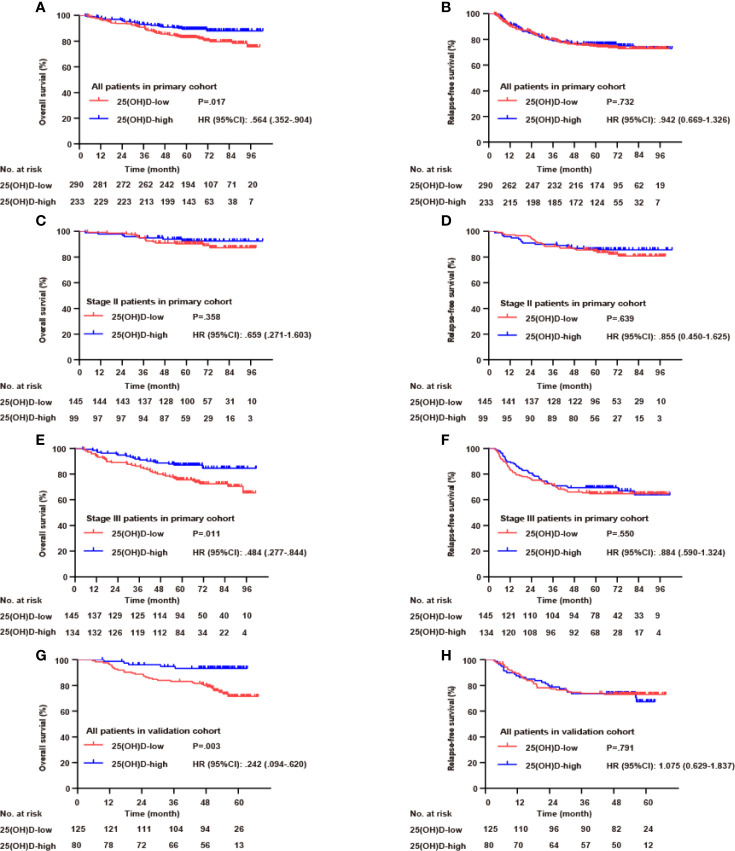
Serum 25(OH)D as a prognostic biomarker in both cohorts. Overall survival (A) and relapse-free survival (B) curves according to serum 25(OH)D levels among patients with CRC in the primary cohort. Overall survival (C) and relapse-free survival (D) curves according to serum 25(OH)D levels among patients with stage II CRC in the primary cohort. Overall survival (E) and relapse-free survival (F) curves according to serum 25(OH)D levels among patients with stage III CRC in the primary cohort. Overall survival (G) and relapse-free survival (H) curves according to serum 25(OH)D levels among patients with CRC in the validation cohort.